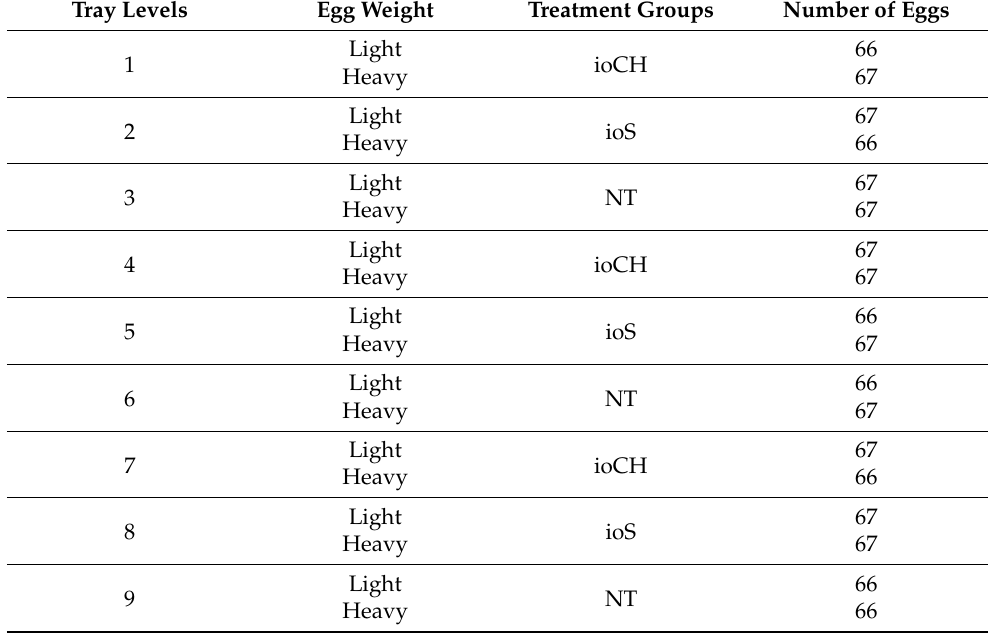
Table 1. Treatment groups in the hatching